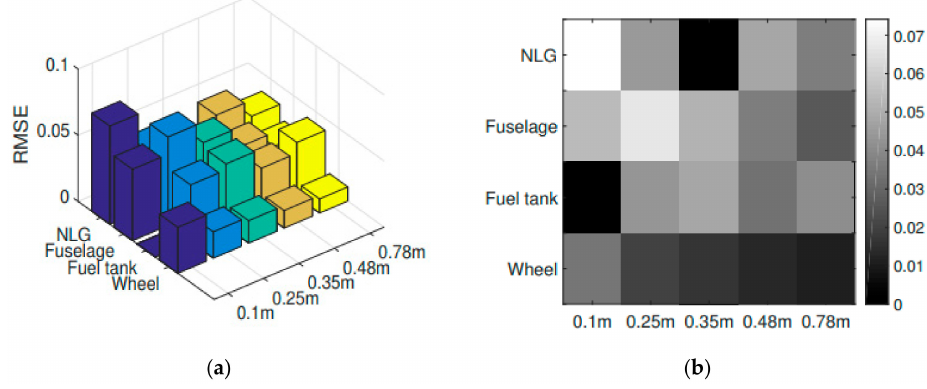
Figure 7. Root mean square error (RMSE) bar plot ( a ) and colormap ( b